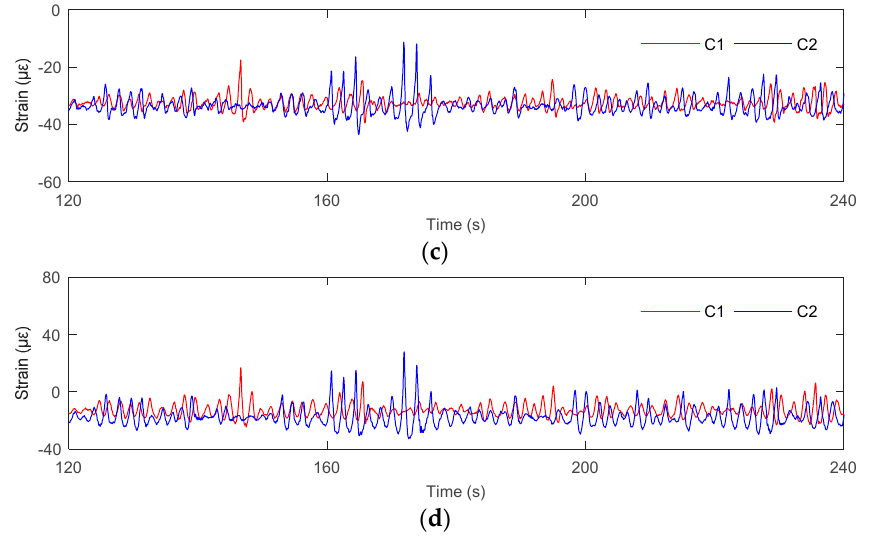
Figure 9. Time-series of the strain response at various measurement positions in storm conditions. ( a )